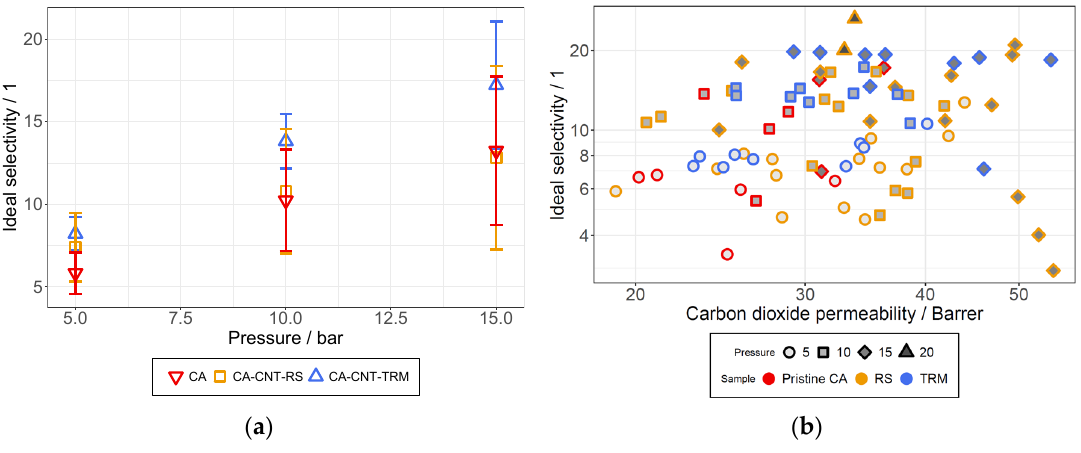
Figure 15. Selectivity of CA membranes at 5, 10, and 15 bar ( a ) and the selectivity against the permeability in dependence of the pressure 5, 10, 15, and 20 bar ( b ).